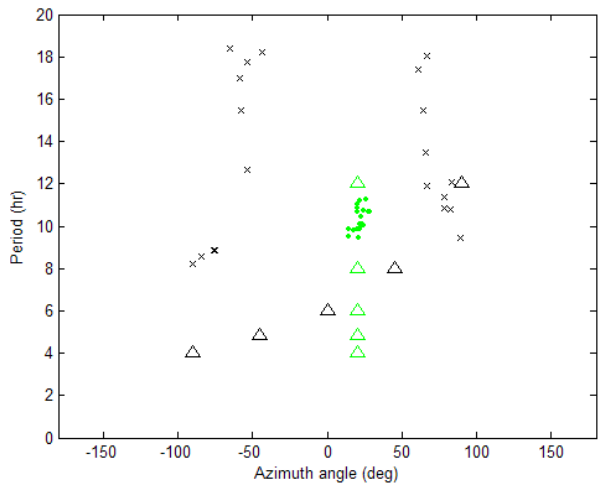
Fig.5 Period vs. azimuth plot of the component waves in Table 2a (by black upward triangle ) and 10 Fig. 5. Period vs. azimuth plot of the component waves in Table 2a the results of hodograph analysis (by black cross ) around each wave packets as listed in Table 3. (by a black upward triangle) and the results of hodograph analysis When all the component waves in Table 2a propagate in same direction with azimuth of 20 (by a black cross) around each wave packets as listed in Table 3. When all the component waves in Table 2a propagate in same di- degrees (see Table 2c) as shown by green upward triangle , the corresponding hodograph rection with azimuth of 20 degrees (see Table 2c) as shown by a analyses were presented by ‘ green dot’. green upward triangle, the corresponding hodograph analyses were presented by a “green dot”.